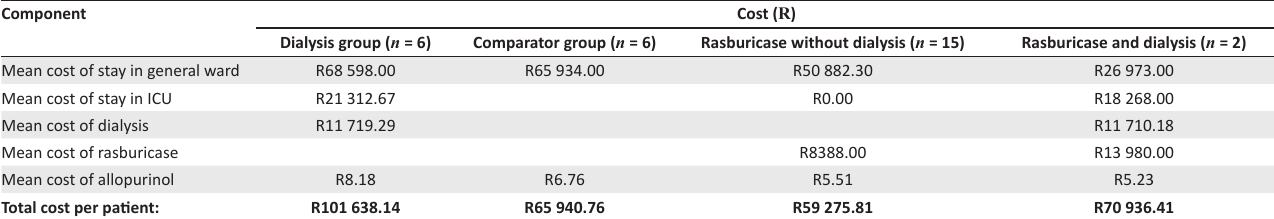
TABLE 5: Mean per patient cost to state. Component Cost ( R